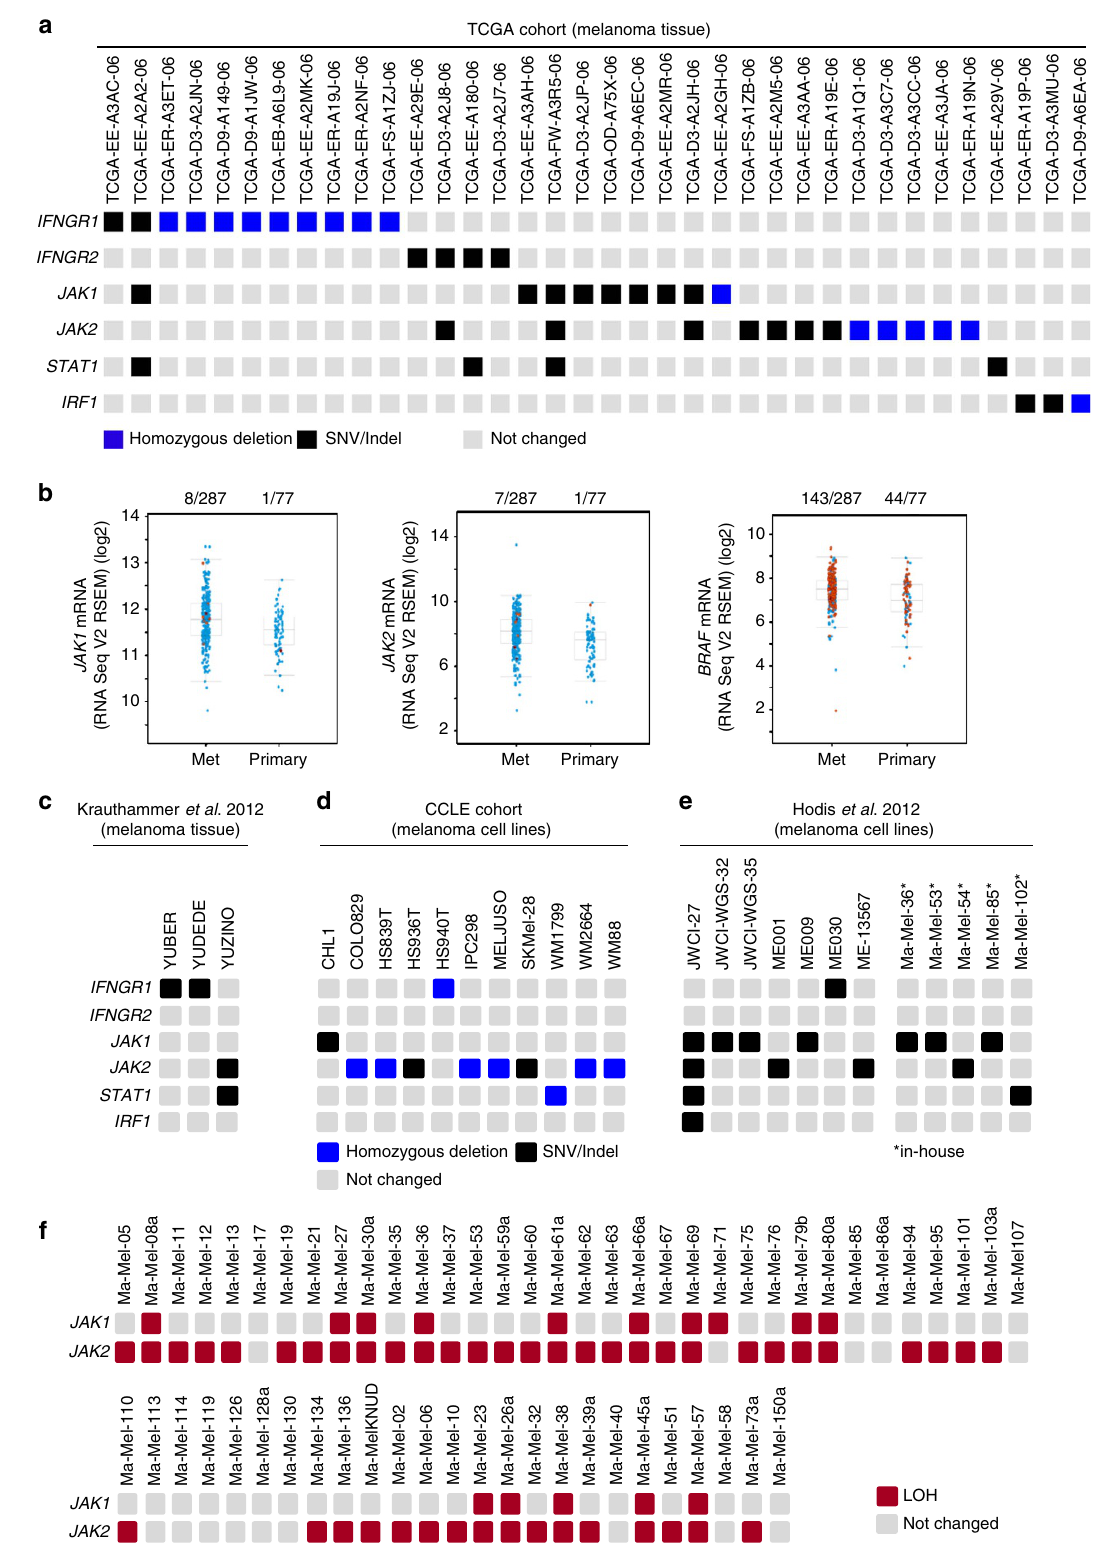
Figure 5 | Mutations in melanoma tissue samples and cell lines. ( a ) Genetic alterations (homozygous deletions, single-nucleotide variants [SNV], small insertions and deletions [Indel]) in components of the type II IFN signalling pathway in TCGA melanoma samples ( n ¼ 287, accessed 31/12/2016). ( b ) Mutations in JAK1, JAK2 and BRAF in the TCGA melanoma dataset stratified by tissue origin (primary tumours vs metastases). y axis, indicates expression of corresponding mRNA. Each circle represents a sample, samples harbouring SNVor Indels are shown in red ( n ¼ 287, accessed 30/12/2016). ( c – e ) Recurrent mutations of type II IFN signalling pathway genes in published datasets 15,19,20 . ( f ) SNP array data from 59 melanoma cell lines 21 show LOH at the JAK1 (Chr. 1p31.3) and JAK2 (Chr. 9p24.1) locus.